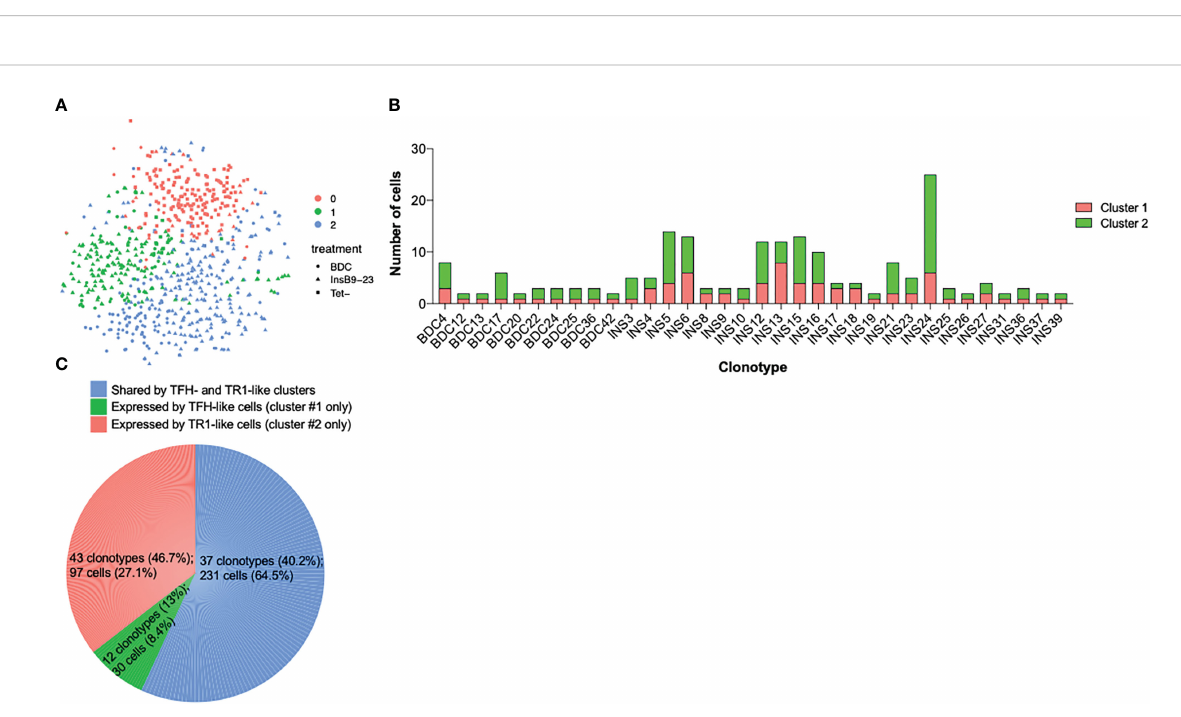
FIGURE 5 Cluster distribution of repeated clonotypic TCR ab pairs within tetramer+ cells of pMHCII-NP-treated mice. (A) Seurat clustering analysis of SMARTseq2-based scRNAseq data for sorted tetramer+ and tetramer – cells from NOD mice treated with BDC2.5mi/IA g7 - or InsB 9-23 /IA g7 -NPs (from n=5 and 15 mice, respectively). Most tetramer+ cells (63.6%) are found in cluster #2 (TR1-like). (B) Sub-cluster distribution of each of the repeated clonotypic TCR ab pairs (found in more than one cell) for tetramer+ cells from NOD mice treated with BDC2.5mi/IA g7 - or InsB 9-23 /IA g7 -NPs. (C) Pie chart displaying the percentage of repeated clonotypes shared by clusters #1 and #2 or expressed only by clusters #1 or #2 among all clonotypes identi fi ed, as well as the number of cells expressing these clonotypes among all cells